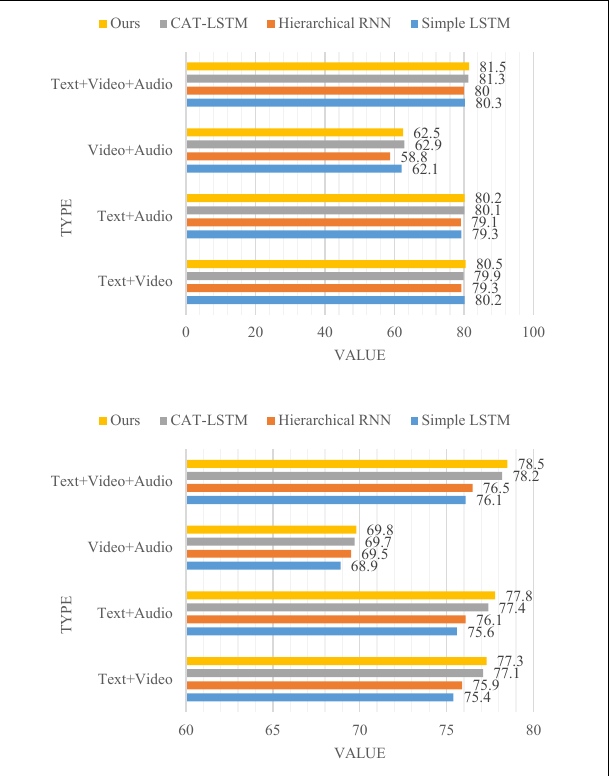
FIGURE 7 | The accuracy of multimodal sentiment analysis in MOSI and MOSEI,